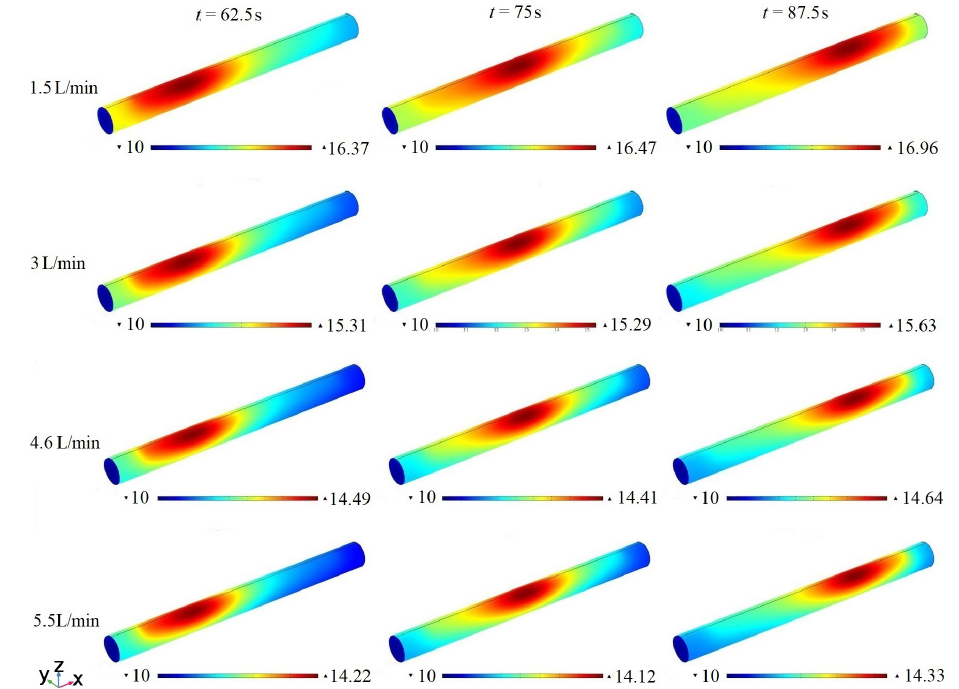
Figure 12. Typical transient temperature distribution of fluid surface at different flow